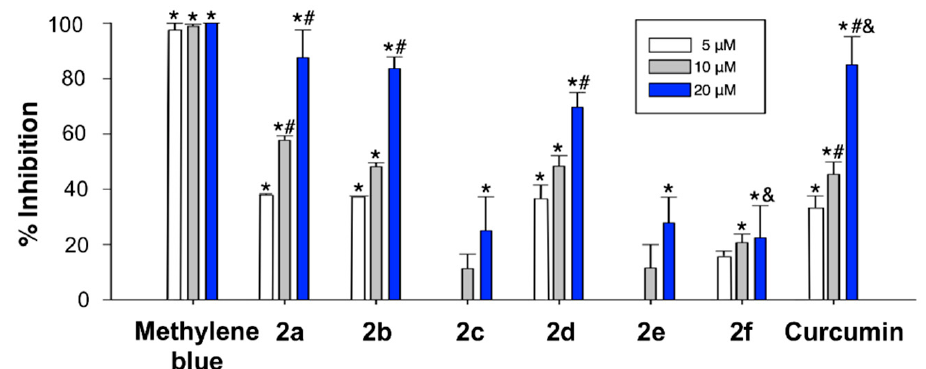
Figure 4. Plot showing the inhibition of aggregation of 100 µ M PHF6 at the endpoint of ThT fluorescence set at 60 min. Effects of curcumin analogues on PHF6 aggregation after 60 min-incubation. The formation of fibrils was determined by the decrease in ThT fluorescence in the absence and presence of curcumin analogues. The samples were incubated at 37 ◦ C, and either 100 µ M of PHF6 in the absence and presence of 5–20 µ M curcumin analogue. Experiments were performed in triplicate. Data are given as the mean lifetime ± SEM for each curcumin analogue concentration of three separate experiments. * Significant differences vs. 100 µ M PHF6; # significant differences vs. 5 µ M; & significant differences vs. 10 µ M ( p < 0.05, Newman-Keuls post-hoc test, in all cases).